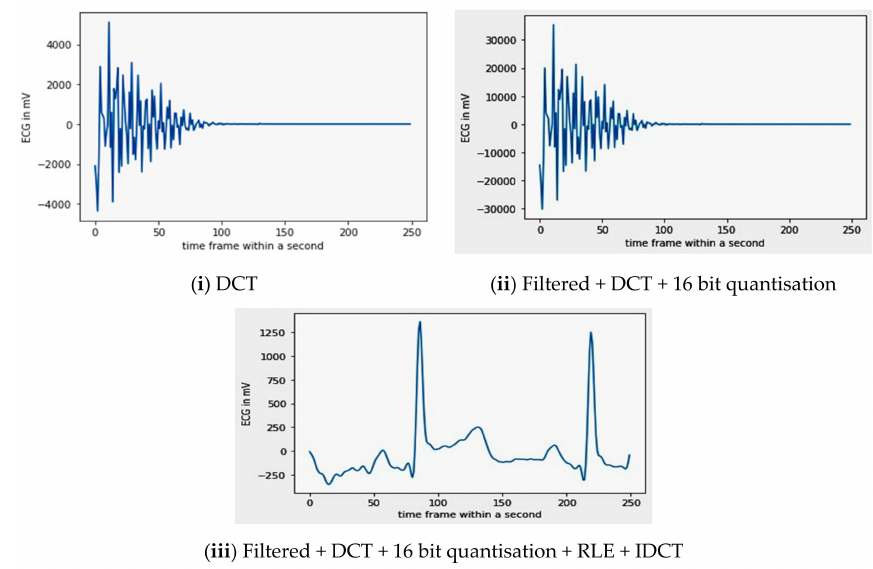
Figure 9. Sample signal representation of compressed and decompressed signals.